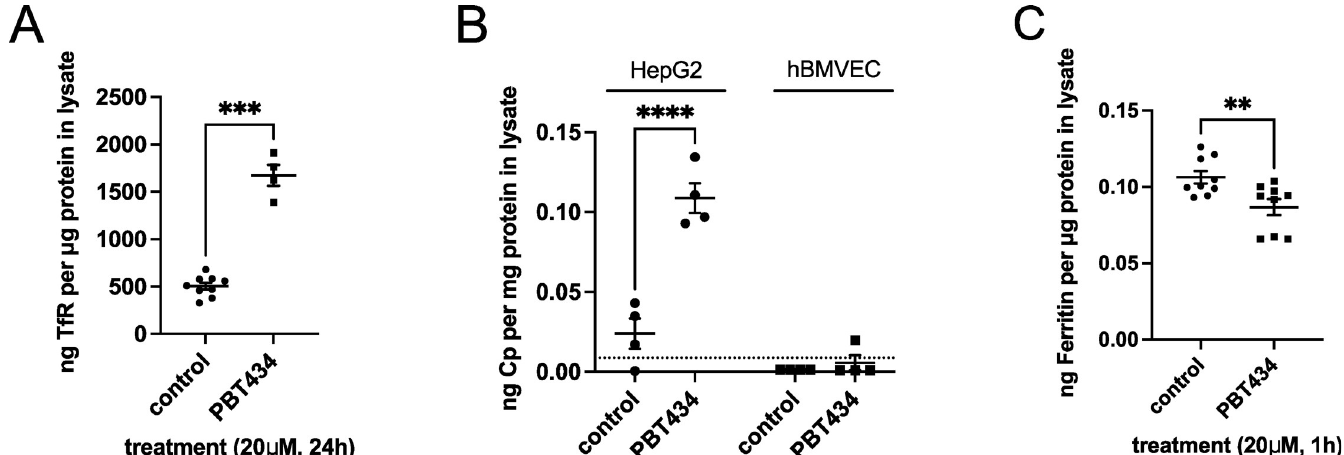
Fig 8. ELISA analysis of iron metabolic protein abundance in PBT434-treated hBMVEC. (A ) hBMVEC were incubated in the absence or presence of 20 μ M PBT434 for 24h. Cell lysates were assayed for transferrin receptor (TfR) by sandwich ELISA and normalized to total protein content. Data are represented as mean ± SEM, n = 4–9 biological replicates. Statistical significance was tested using t-test; ���� , p < 0.0001, compared to control. The mean values were: 505 ± 109 (control) and 1672 ± 223 ng TfR/ μ g total cell protein (+PBT434). ( B ) hBMVEC or HepG2 were grown in monolayers for 24h in media containing serum, then incubated in the absence or presence of 20 μ M PBT434 in media without serum for an additional 24h. Following incubation, cells were treated with PI-PLC (0.5 U/ml) for 1h to release any GPI-anchored cell surface proteins. Media was collected, concentrated, assayed for Cp protein by sandwich ELISA and normalized to total protein content. Data are represented as mean ± SEM, n = 4 biological replicates. Statistical significance was tested using t-test; ���� , p < 0.0001, compared to control. The lower sensitivity limit of this kit is reported to be 0.12 ng/ml (or 0.0088 ng/mg protein average) indicated by the dashed line. ( C ) hBMVEC were loaded with 1 μ M Fe 2+ -citrate in RPMI+serum media for 24h, then washed and incubated in the absence or presence of 20 μ M PBT434 for an additional 1h. Cell lysates were assayed for ferritin protein by sandwich ELISA and normalized to total protein content. Data are represented as mean ± SEM, n = 9 biological replicates. Statistical significance was tested using t-test; � , p < 0.05, compared to control. The mean values were: 106 ± 4 (control) and 87 ± 5 pg Ft/ μ g total cell protein (+PBT434).